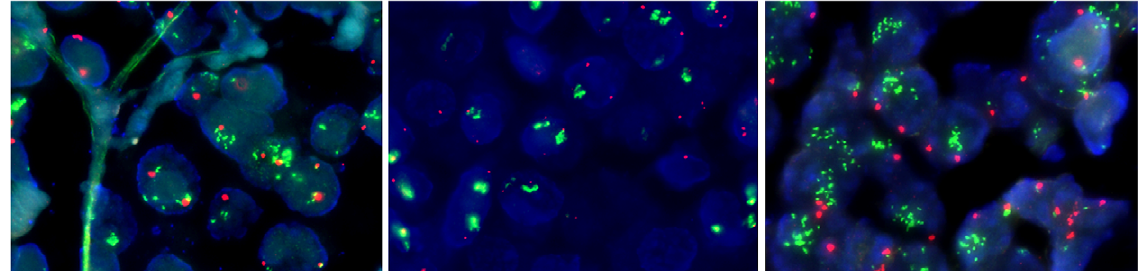
Fig. 1. ESR1 (green) amplification by FISH in 3 multiplex ligation-dependent probe amplification (MLPA)-amplified patients. CEP6 is indicated in red.